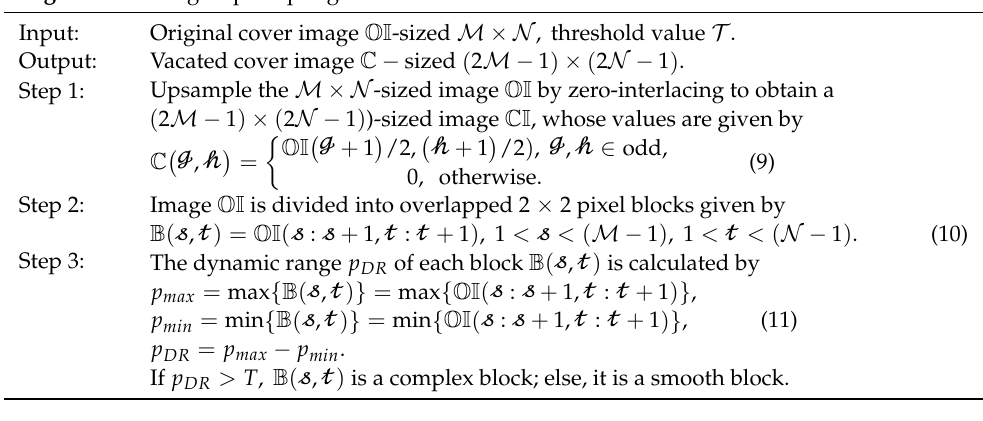
Algorithm 2 Data Embedding for Complex Blocks